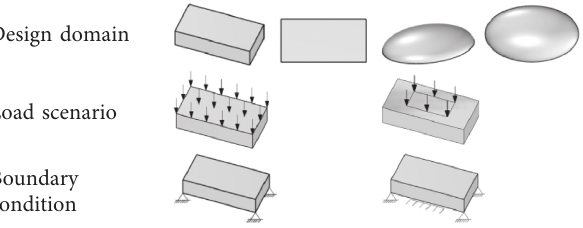
Table 8: Parameters for large-scale spatial